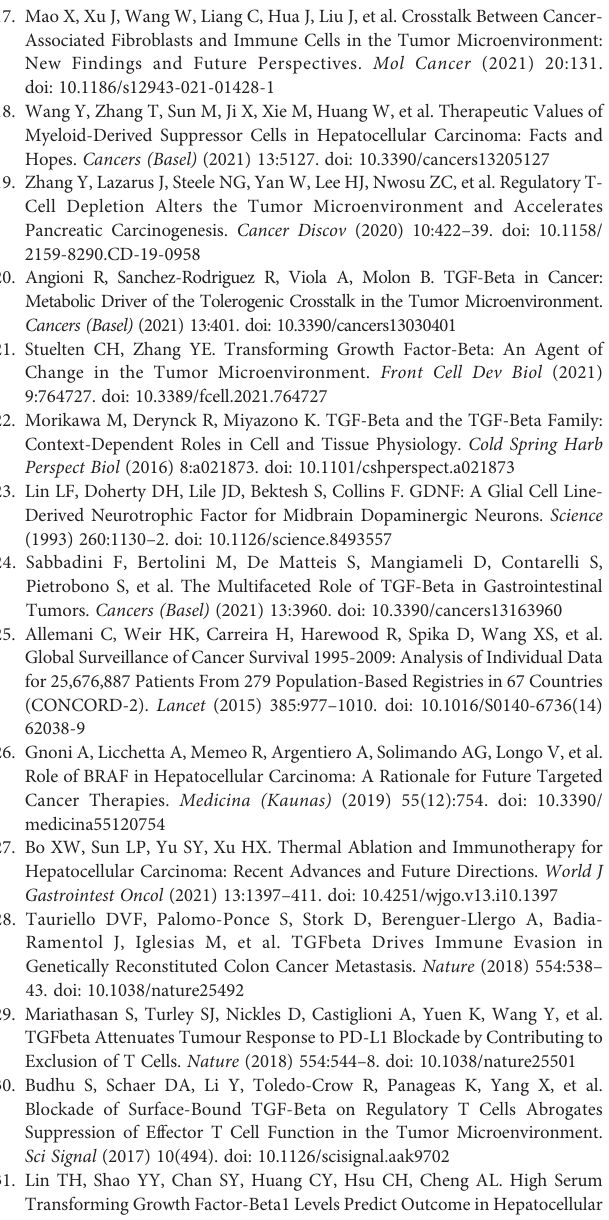
Supplementary Figure 1 | Con fi rmation of prognosis model. Lasso regression analysis was implemented to reduce model complexity and prevent over- fi tting, and the obtained coef fi cients as shown in Figure 1C was used to calculate the risk score (A) and survival time in years (B) . (C) . Principal Component Analysis (PCA) was applied to further validate the effectiveness of the prognosis model and to display the difference between the two groups (high risk and low risk) using package